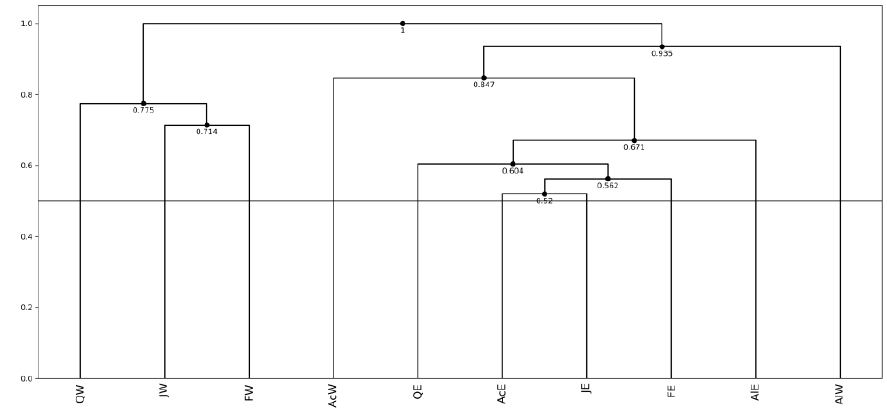
Table 10. Average compactness of each feature in each clustering step. Figure 17. Results of clustering for hardwoods data (eight features). Figure 17. Results of clustering for hardwoods data (eight features).